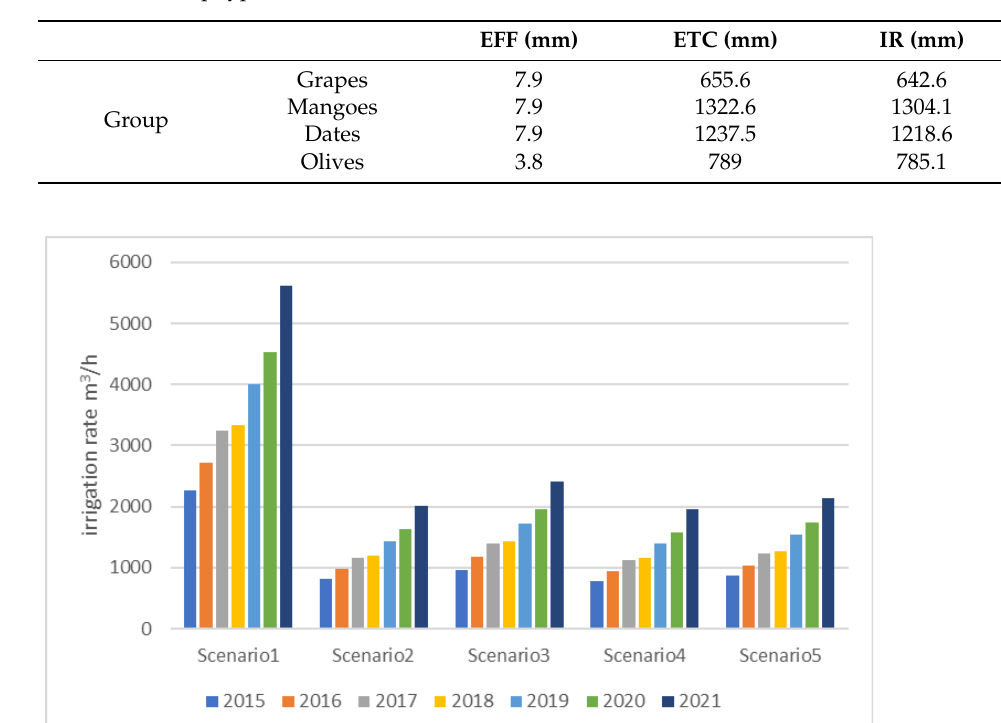
Figure 9. The consumption rate recorded by each proposed scenario. Table 2. The effective rain (EFF), potential crop evapotranspiration (ETC), and irrigation required (IR), for each crop type.